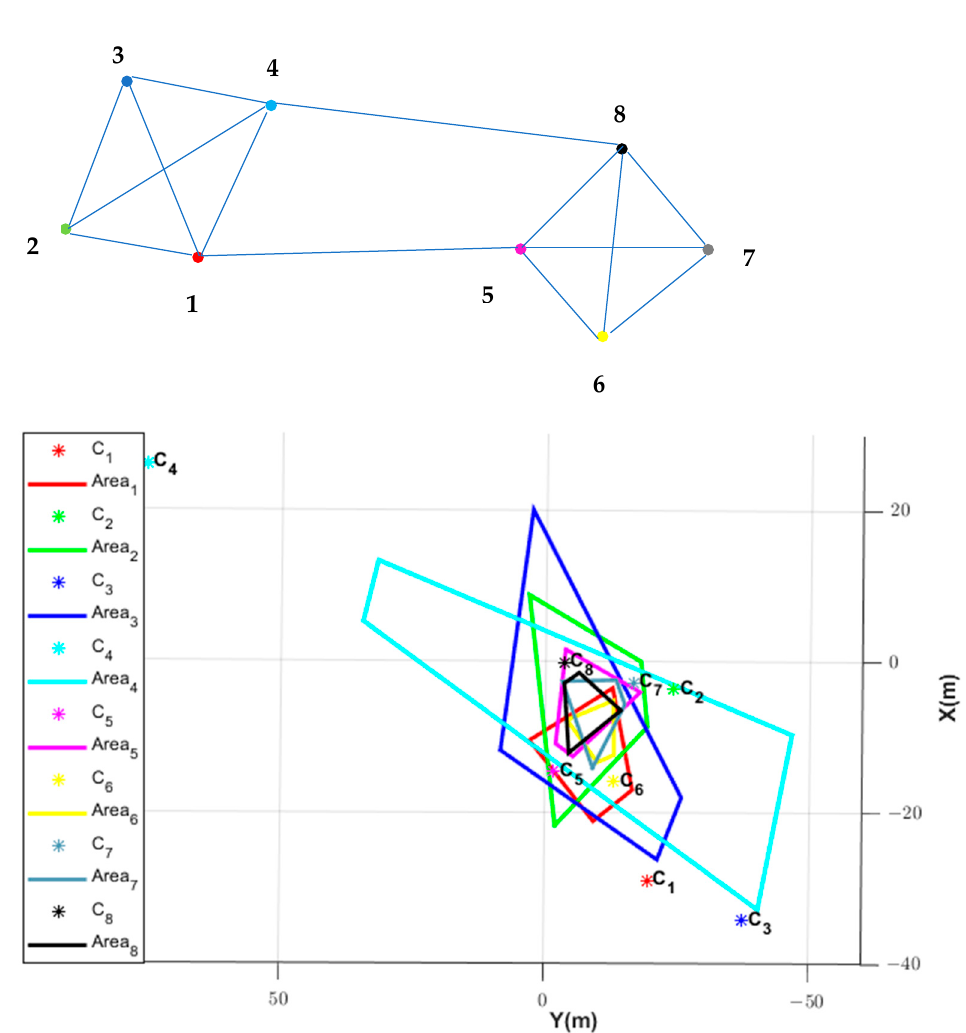
Figure 18. Top: network communications topology. Bottom: projection of the FoVs from each of the 𝑁 (cid:3046) = 8 cameras on the ground reference plane.